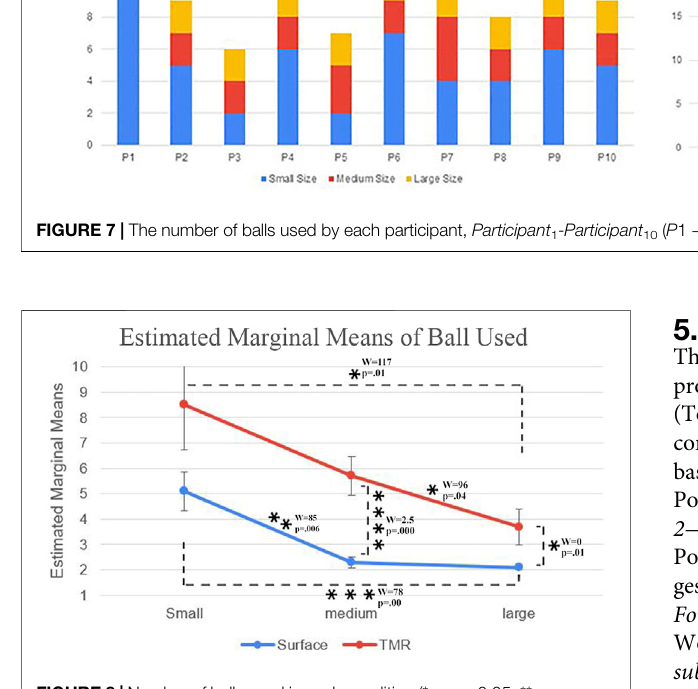
Frontiers in Virtual Reality |